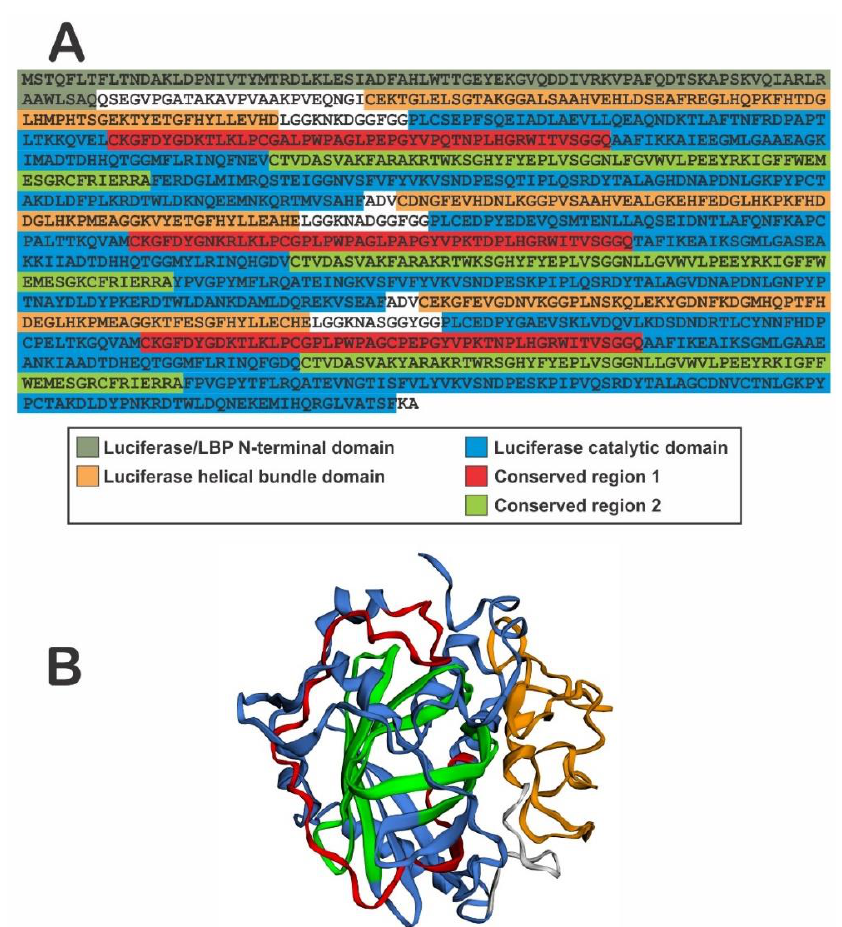
Figure 2. ( A ) Sequence of P. lunula LCF protein A (GenBank AAL40676) showing the Luciferase / LBP N-terminal, helical bundle and catalytic domains, as well as the two conserved regions within the catalytic domain. ( B ) Our prediction of the 2D / 3D structure of the first helical bundle (yellow) and first catalytic domain of the LCF (blue) of P. lunula (GenBank AAL40676), showing the conserved regions 1 (red) and 2 (green), made with Phyre2 web server and visualized with EzMol, as described in the